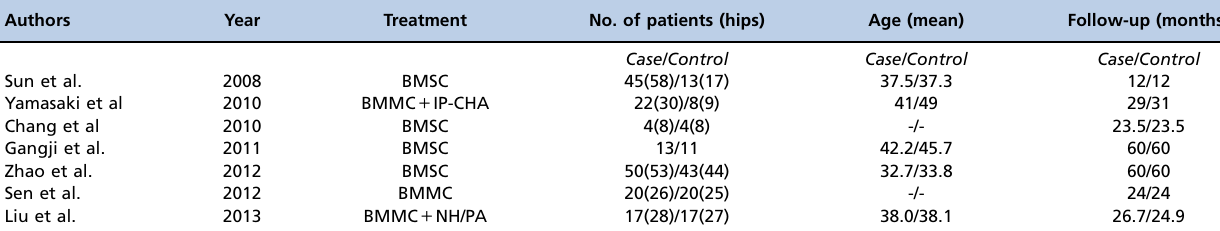
Table 1 - Characteristics of the 357 hips identified from the literature.